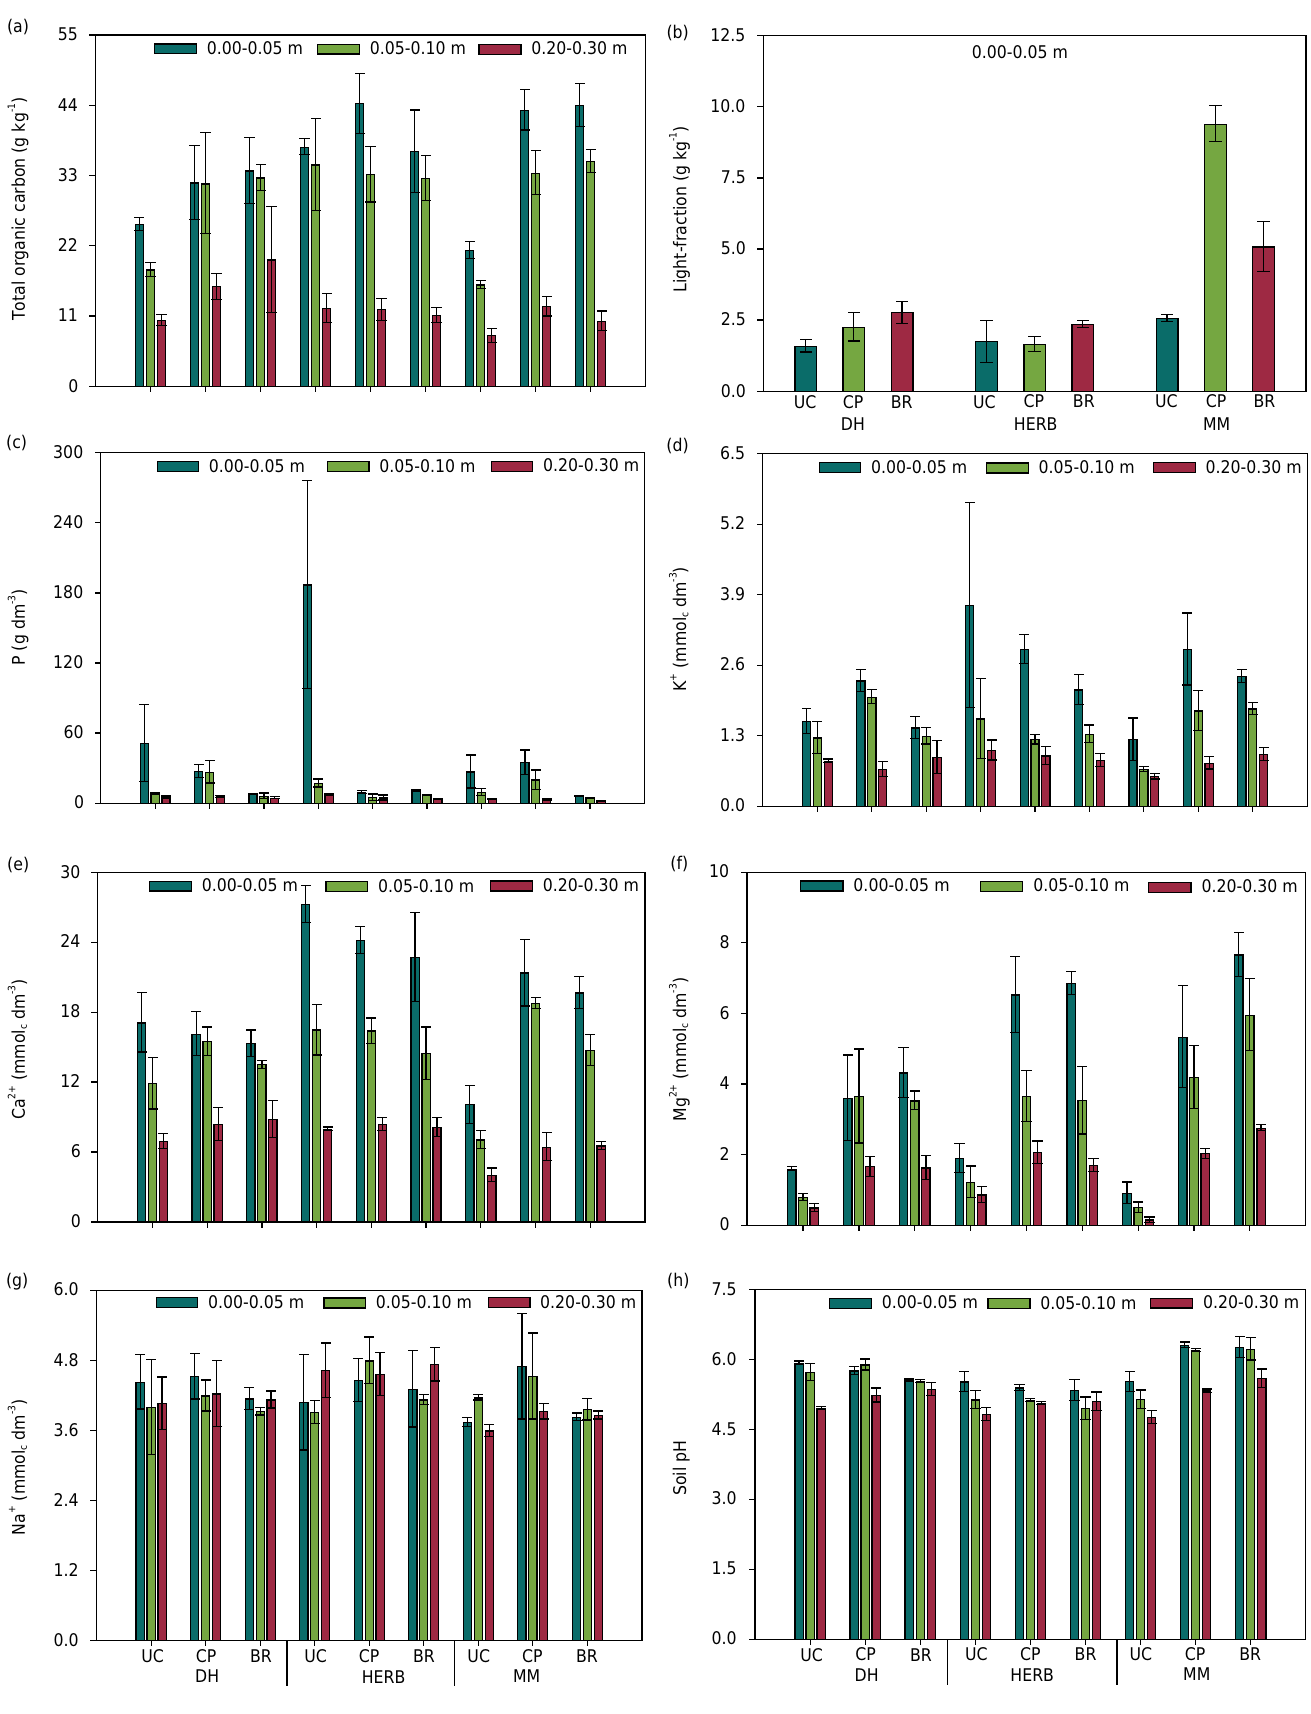
Figure 3. Chemical properties, total organic carbon, and light-fraction organic matter of an Arenic Kandiustults cultivated with early dwarf cashew under different management systems in the municipality of Pacajus, Ceará, Brazil. Error bars represent the standard error of the mean (n = 3). HERB: herbicide; DH: disc harrowing + crowning; MM: mechanical mowing + crowning; UC: under the canopy; CP: limit of the canopy projection; and BR: between the crop